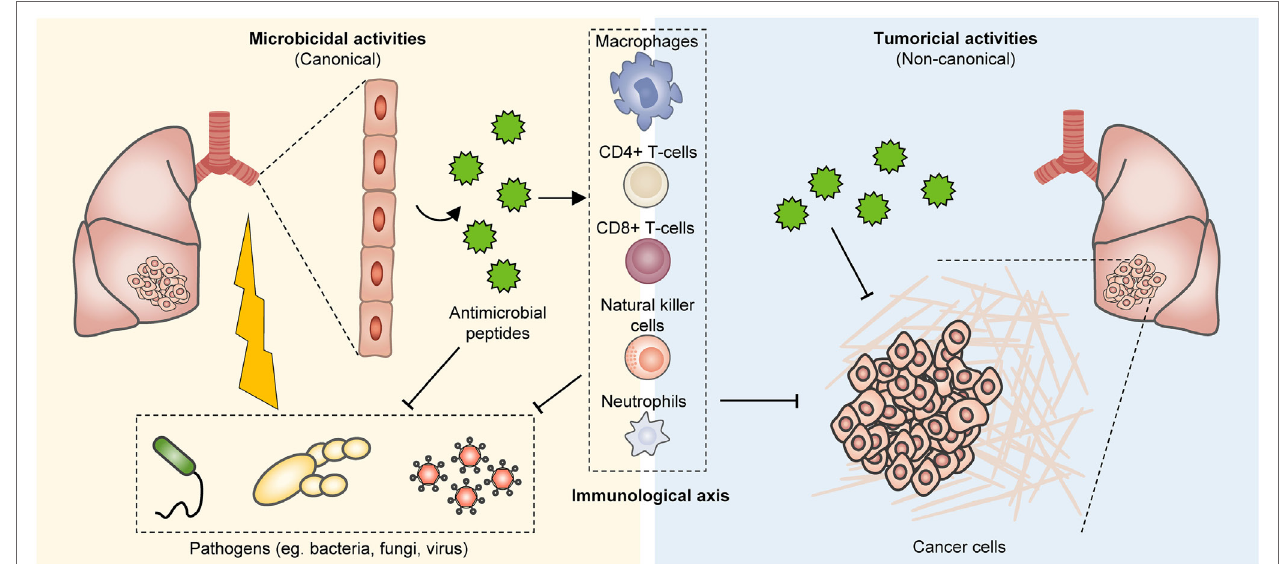
FiGURe 1 | Bioproduction of antimicrobial peptides (AMPs) and their tumor suppressive effects. In humans, AMPs are present at various tissues, including the epithelium of the skin, respiratory system, and gastrointestinal tract, as well as the immune system. These peptides can effectively impinge on a broad spectrum of microorganisms including fungi, bacteria, and viruses. However, they also restrain tumor growth and their immunostimulatory properties further co-opt anticancer immunity for enhanced tumor